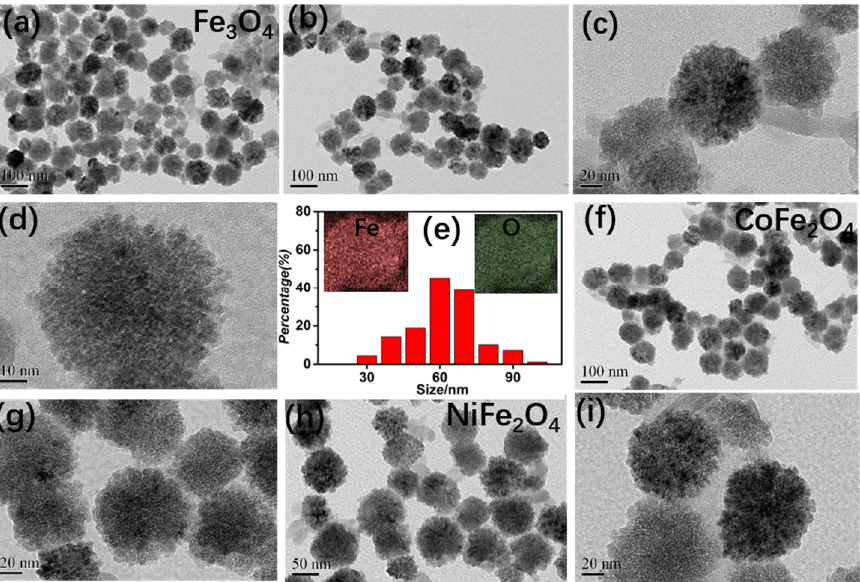
Figure 3. Typical TEM images and size distribution of chain-like ferrites: ( a – e ) Fe 3 O 4 ; ( f – g ) CoFe 2 O 4 ; ( h , i ) NiFe 2 O 4